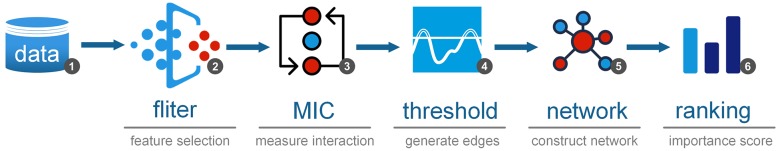
Schematic representation of data processing and analysis.Each icon denotes an analytical process. Icon 1 denotes data containing miRNAs and proteins. Icon 2 shows the feature selection process, which includes XGBoost and random forest algorithms. Icon 3 indicates calculation of the MIC value for every two nodes in the network, which represents the interaction between nodes. Icon 4 is the process that generates edges in the network by setting a specific threshold of MIC. Icon 5 represents the construction of a multilayer network. Icon 6 is the final step of analysis process that gives each node an importance score related to breast cancer.